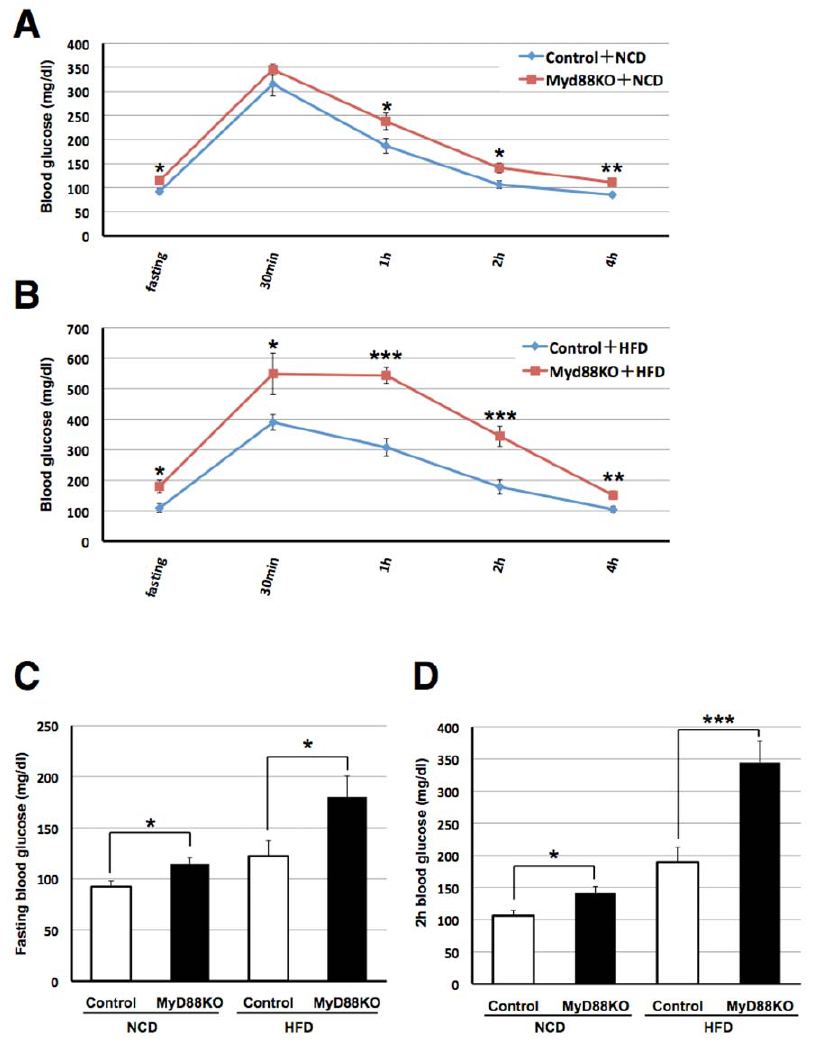
Figure 1. MyD88-deficiency increases the risk of diabetic mellitus. Both genotypes were fed a NCD until 6 weeks of age and then fed a NCD or HFD for 10 weeks. Mice were fasted for 16 h (from 18:00 to 10:00) and subjected to a glucose tolerance test (GTT). We measured circulating levels of glucose at the time indicated (0.5-4 h). ( A ) NCD-fed mice. ( B ) HFD-fed mice. ( C ) NCD- and HFD-fed mice, which were fasted for 16 h. ( D ) Glucose levels after GTT (2 h time point) of each genotype of mice fed the NCD or HFD. n=6 , 12/group. * p , 0.05, ** p , 0.01, *** p , 0.001 v.s. control mice.